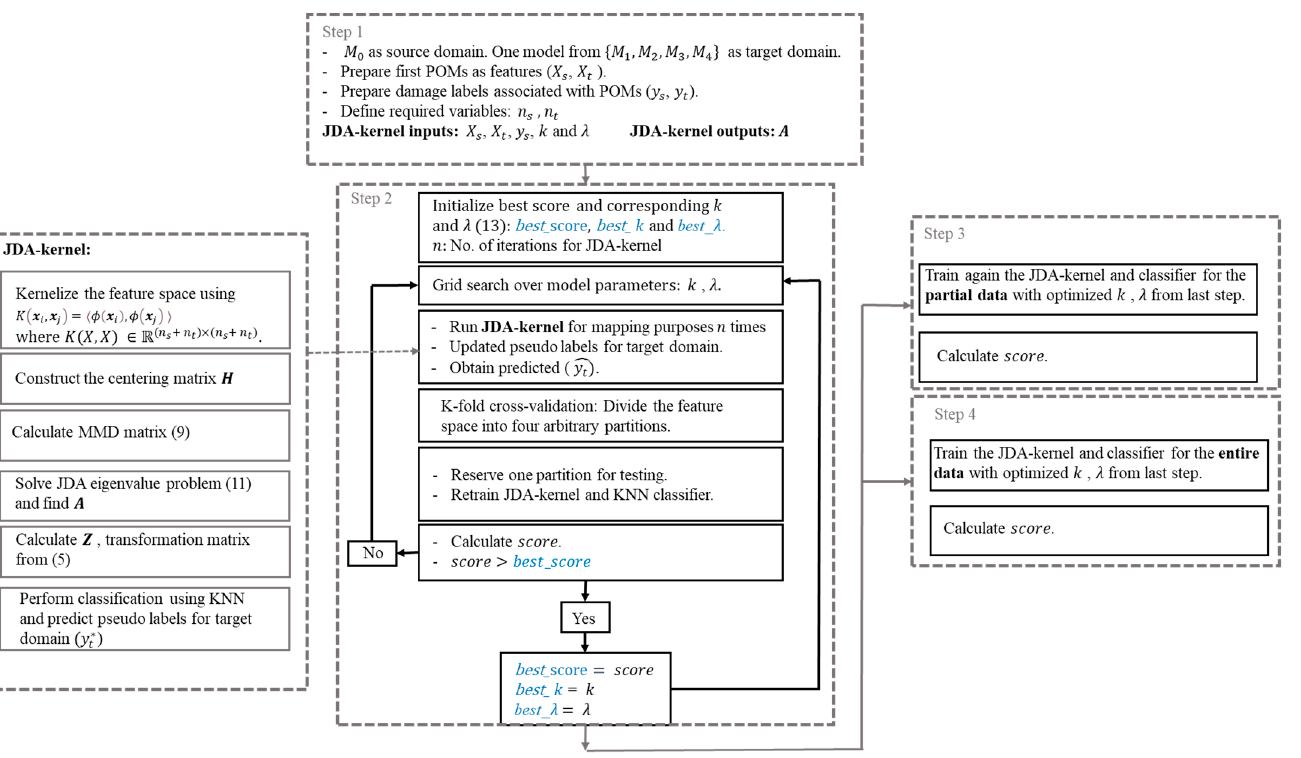
Figure 3. TL process for training, cross validation, and hyperparameter tuning .